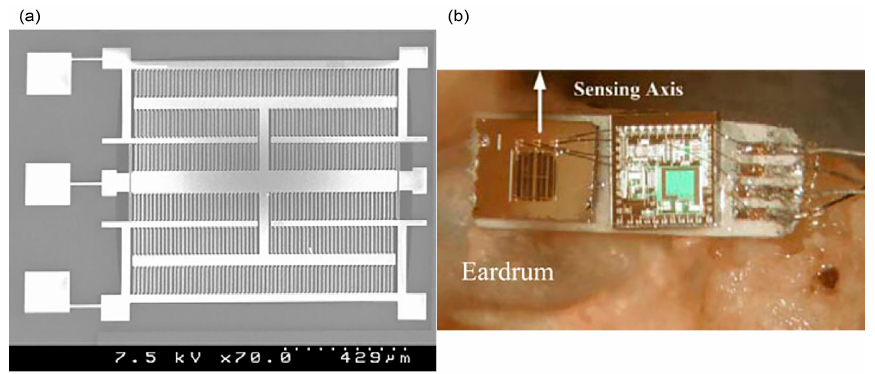
Figure 21. ( a ) The proposed fully implantable microphone at umbo in the middle ear. ( b ) The 2D layout of the accelerom- eter with differential capacitances. The capacitive sensed-fingers are connected to the proof mass through a system of microlevers [82]. Reprinted by permission from Springer Nature Customer Service Centre GmbH: Springer Nature MI- Figure 22. ( a ) The micrograph image of the fabricated capacitive accelerometer-based microphone. ( b ) The accelerometer CROSYSTEM TECHNOLOGIES Numerical simulation and modelling of a novel MEMS capacitive accelerometer based is interfaced with the low-noise differential capacitance-to-voltage conversion circuitry and then implanted onto umbo. © microphone for fully implantable hearing aid, A. Dwivedi et al., COPYRIGHT (2019). 2012 IEEE. Reprinted, with permission, from [83].